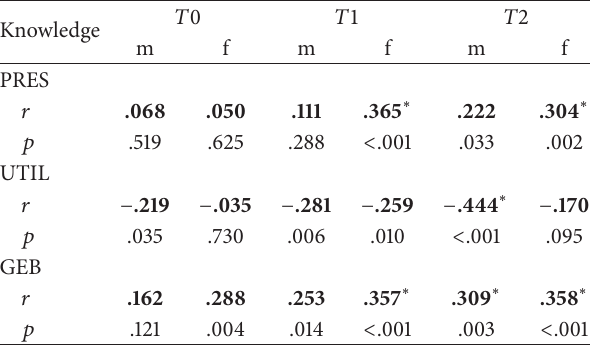
Table 2: Correlations between knowledge scores with 2-MEV